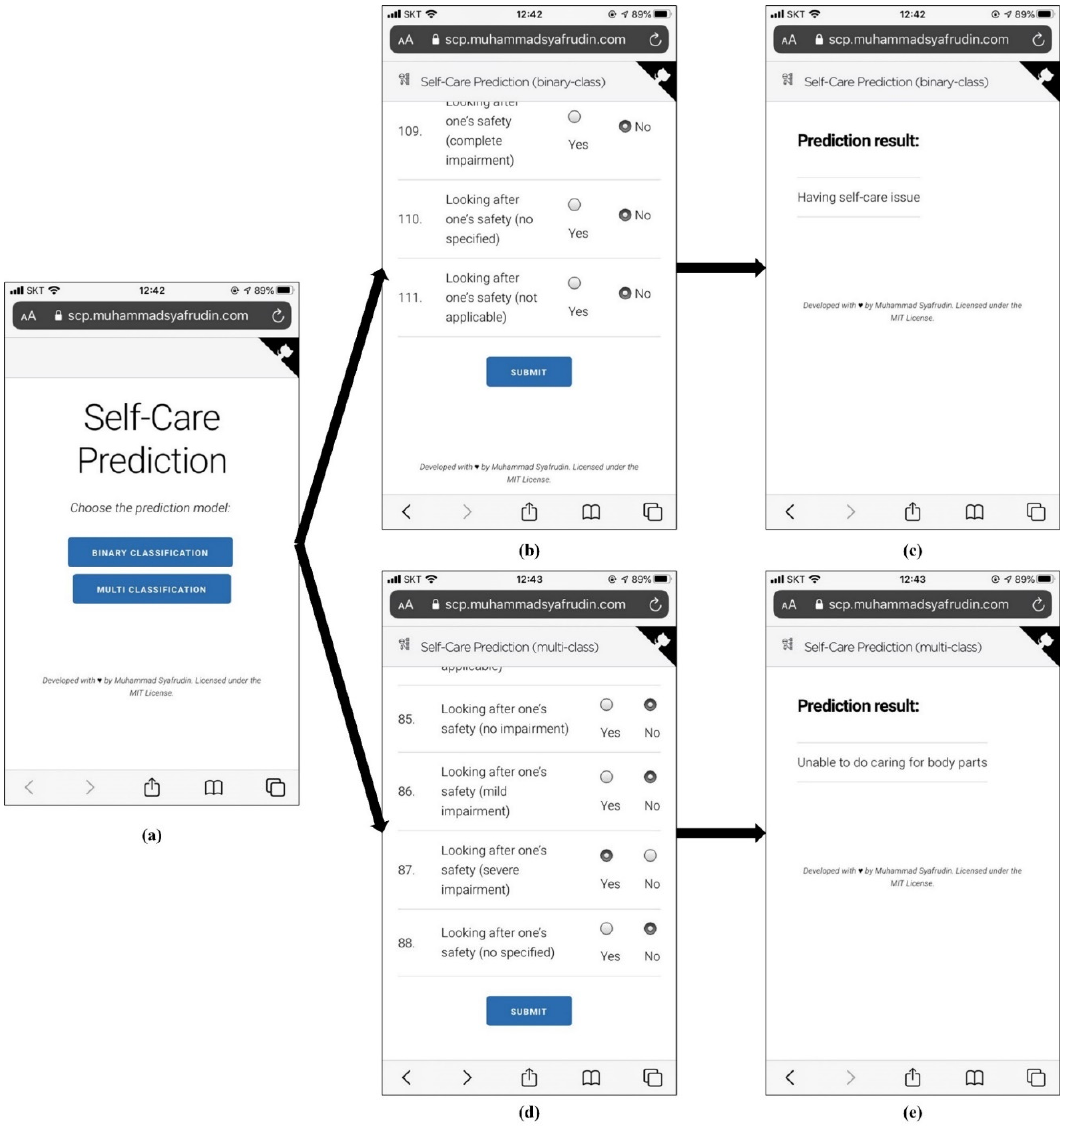
Figure 7. Prototype of web-based self-care prediction: ( a ) menu page, ( b ) Binary-class diagnosis form and ( c ) its prediction result, ( d ) Multi-class diagnosis form and ( e ) its prediction result.